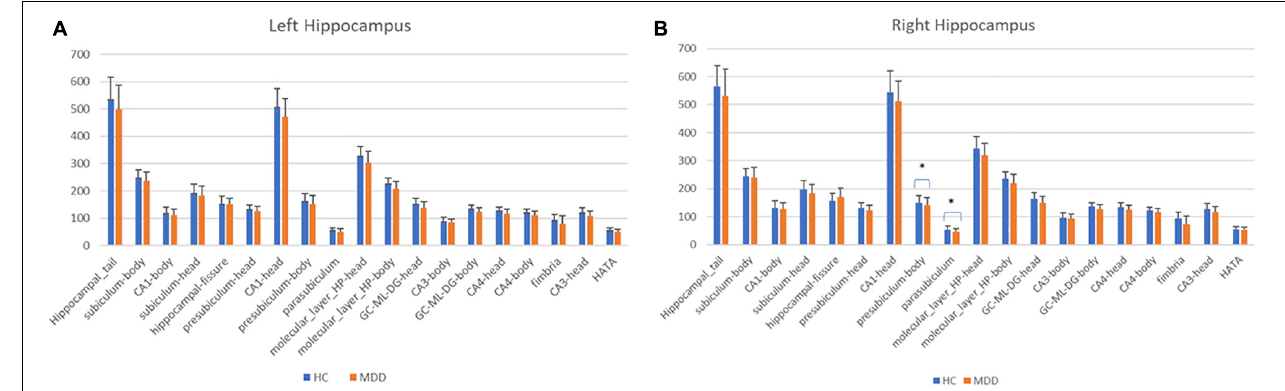
FIGURE 3 | Subfield volumes in hippocampus at left (A) and right (B) . Bar charts show the mean hippocampal subfields volumes (mm 3 ) of 77 HC (Blue) and 76 MDD (Orange). Vertical bars mean standard deviations. Asterisks show statistically significance ( p < 0.05). Linear regression analyses showed significant difference between HC and MDD only in the right presubiculum-body and right parasubiculum adjusted for total intracranial volume, age, and sex ( p < 0.01 and p = 0.04, respectively). There was no significance in other subfields ( p > 0.05). HC, healthy controls; MDD, Major depressive